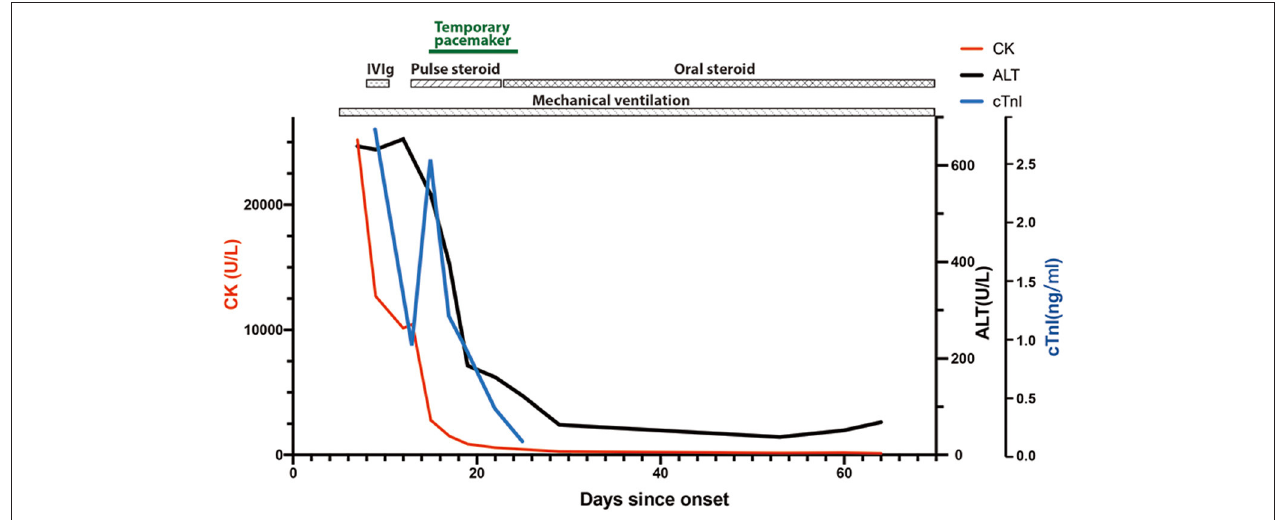
FIGURE 1 | Illustration of the main laboratory markers and treatment of this